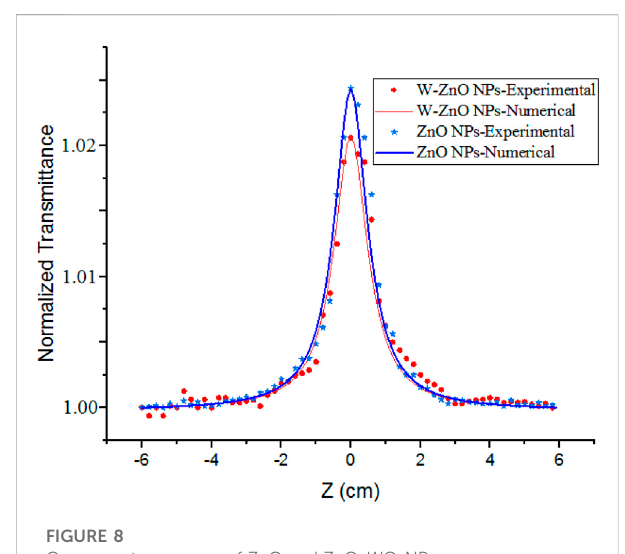
FIGURE 8 Open aperture curves of ZnO and ZnO-WO 3